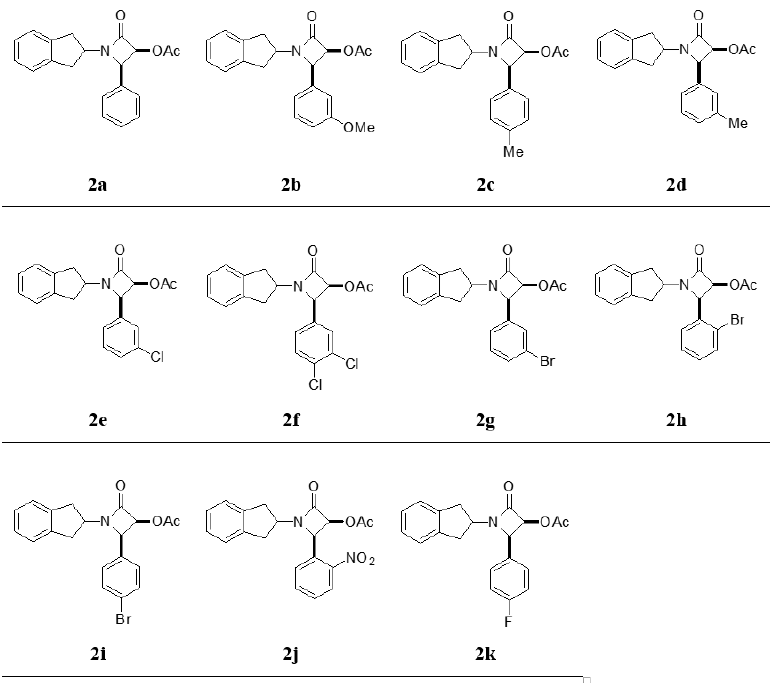
Figure 2. The chemical structures of the investigated β -lactam derivatives ( 2a – k ).